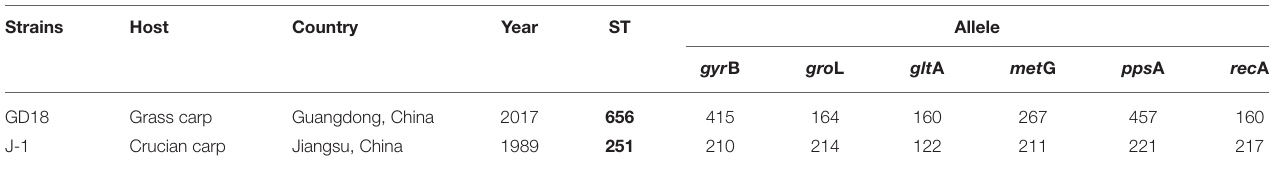
TABLE 2 | The multilocus sequence typing (MLST) of A. hydrophila